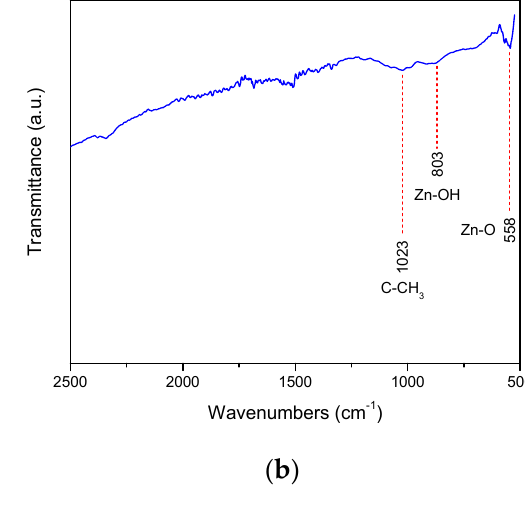
Figure 5. FT-IR spectra: ( a ) ZnO N ; ( b ) ZnO A .